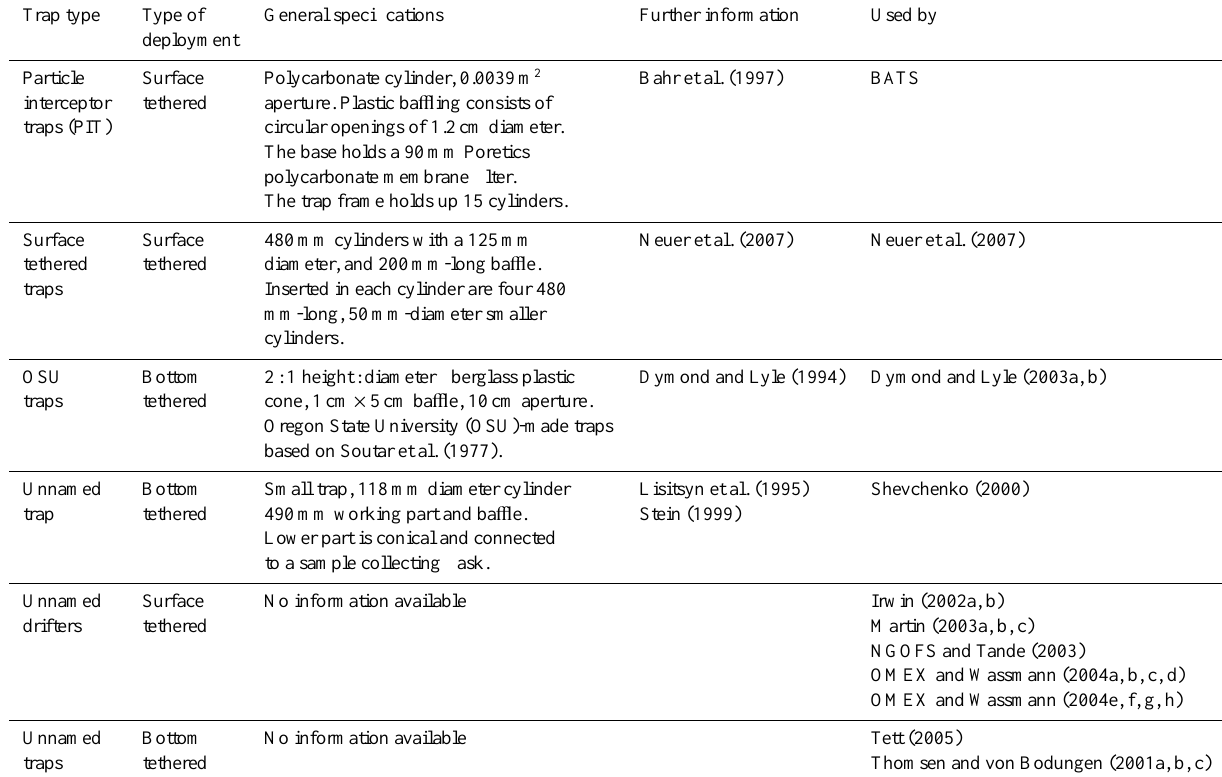
Table 4. Sediment-trap specifications